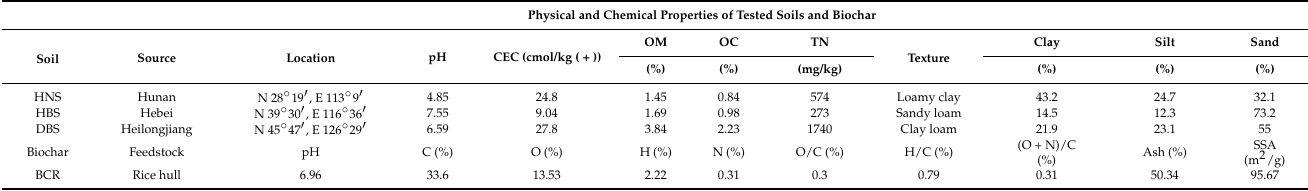
Table 1. Physical and chemical properties of tested soils and